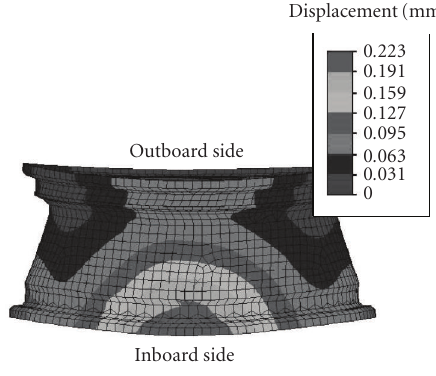
Figure 7: The end view of the deformed rim (view from θ = 0 ◦ direction).